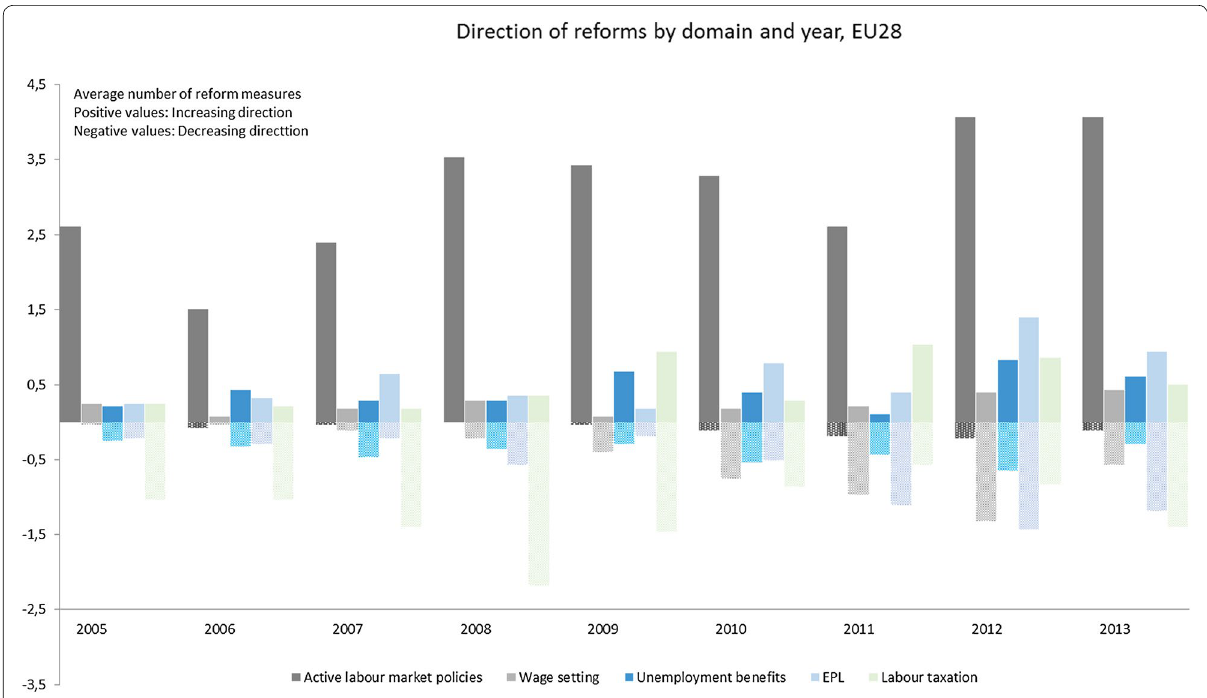
Fig. 5 Employment protection reforms in the EU (LABREF) ( Source Turrini et al. (2015) and Kiss